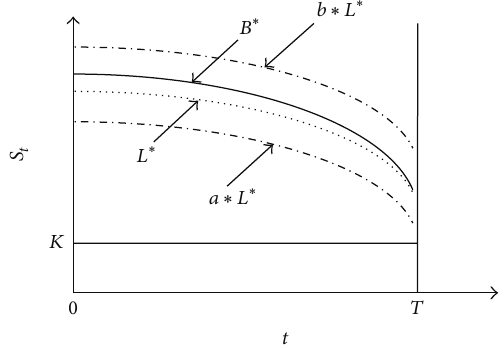
Figure 2: Lower bound on the early exercise